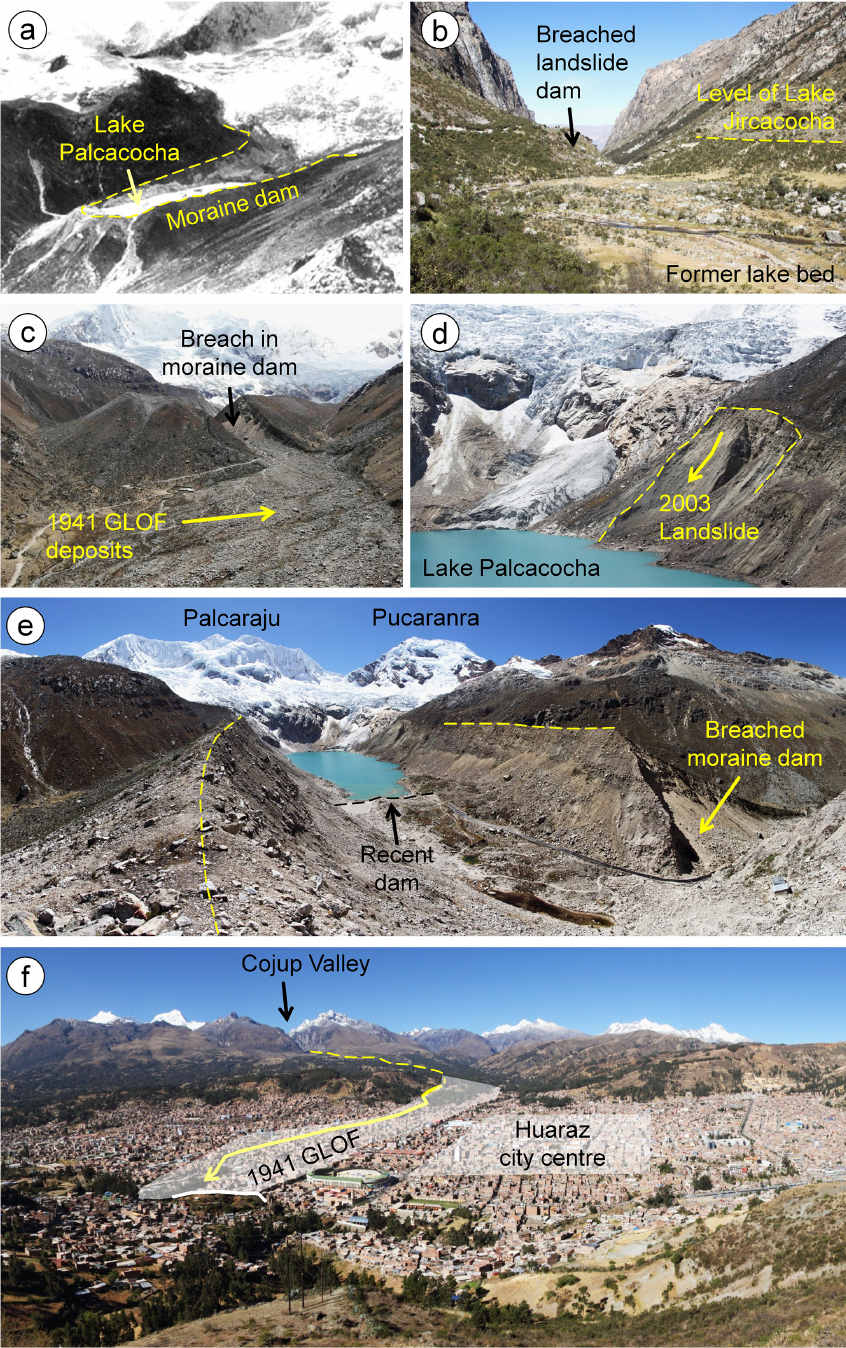
Figure 2. The Quilcay catchment from Lake Palcacocha down to Huaráz. (a) Lake Palcacocha in 1939, two years prior to the 1941 event. (b) The site of former Lake Jircacocha with the breached landslide dam and the former lake level. (c) Breached moraine dam and 1941 GLOF deposits, seen from downstream. (d) Left lateral moraine of Lake Palcacocha with landslide area of 2003. (e) Panoramic view of Lake Palcacocha, with the breach in the moraine dam and the modern lake impounded by a smaller terminal moraine and two artificial dams. (f) Panoramic view of Huaráz with city centre and approximate impact area of the 1941 event. Note that a small part of the lowermost portion of the impact area is hidden behind a hillslope. Photos: (a) Hans Kinzl, 1939 (Kinzl and Schneider, 1950); (b) Martin Mergili, July 2017; (c) Gisela Eberhard, July 2018; (d) and (f) Martin Mergili, July 2017.